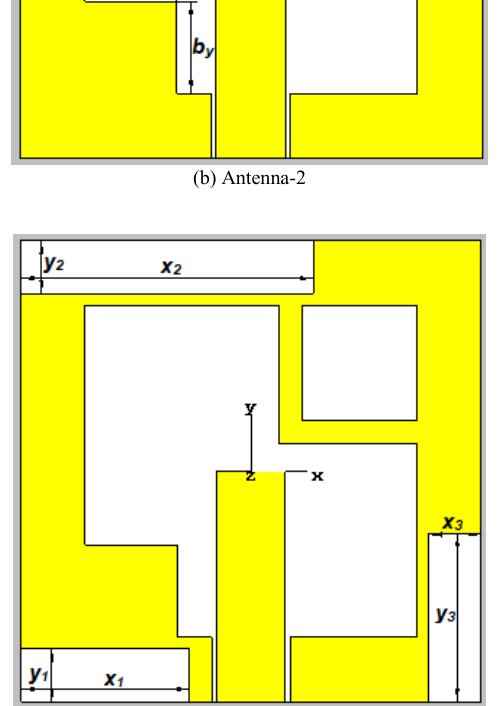
Fig. 1. Step-wise development of the prototype